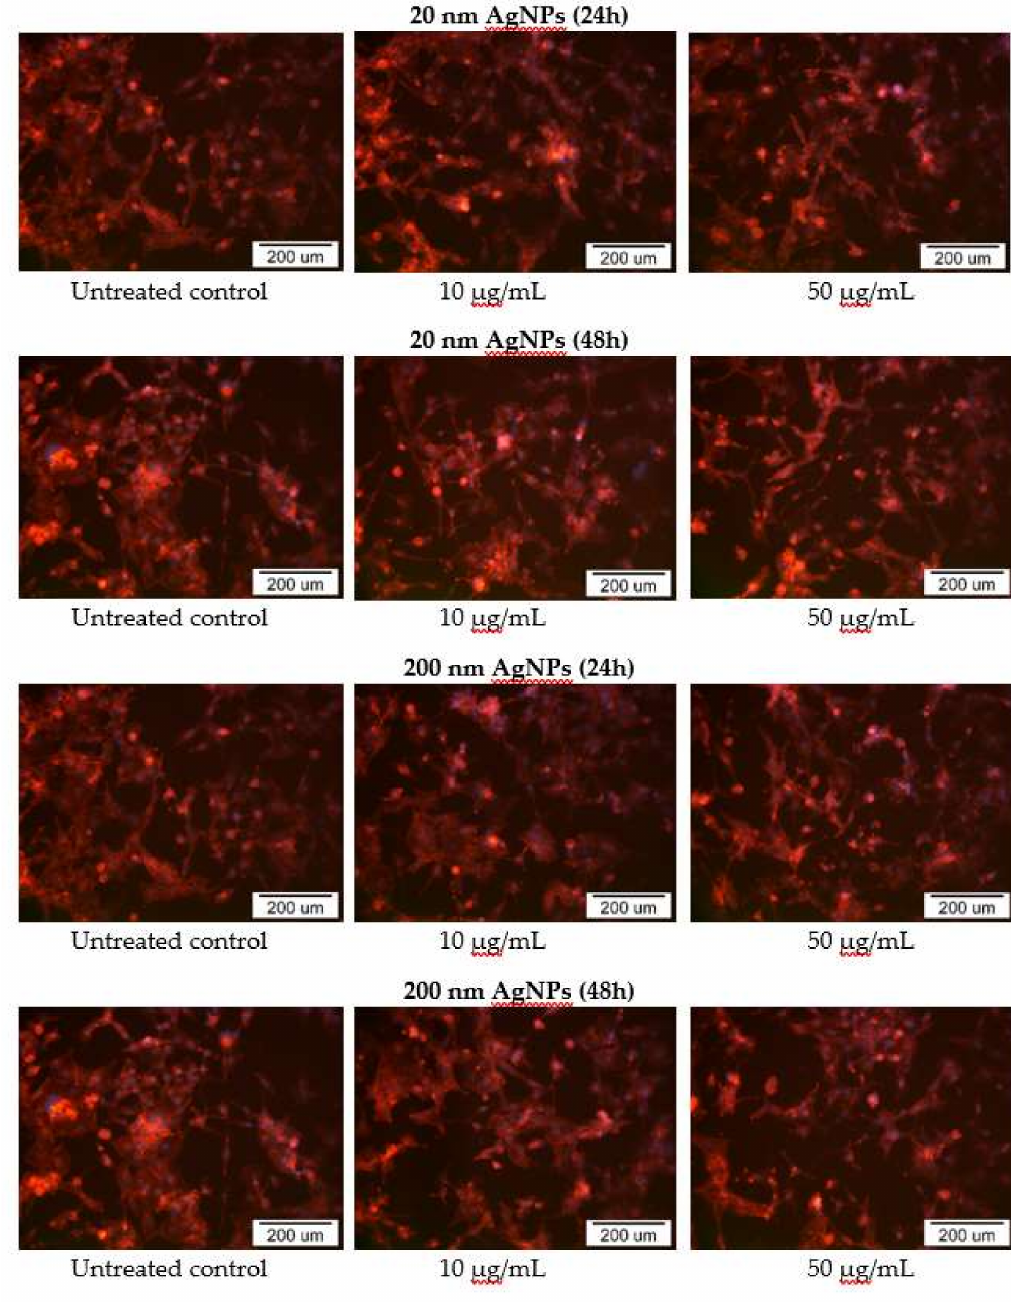
Figure 6. Phalloidin-TRICT staining of MDA-MB-436 cells actin cytoskeleton after incubation with 20 and 200 nm AgNPs solutions. Additional DAPI staining was performed to dye cells